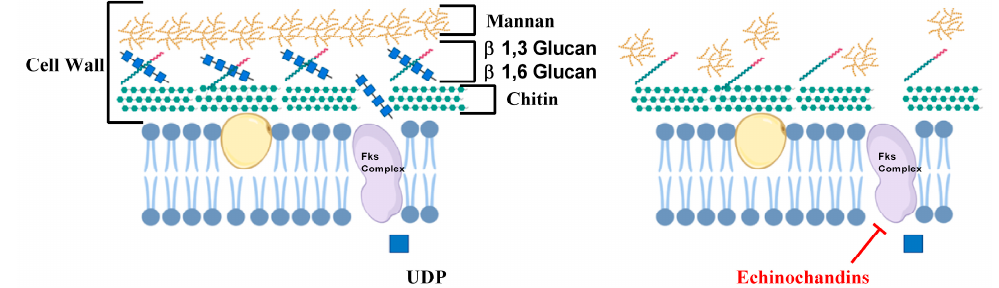
Figure 2. Role of echinochandin in inhibiting cell wall biosynthesis. Fks complex comprises of three proteins Fks1p, Fks2p and Fks3p that utilizes UDP-glucose (UDP) to synthesize β 1-3 glucan. (Images